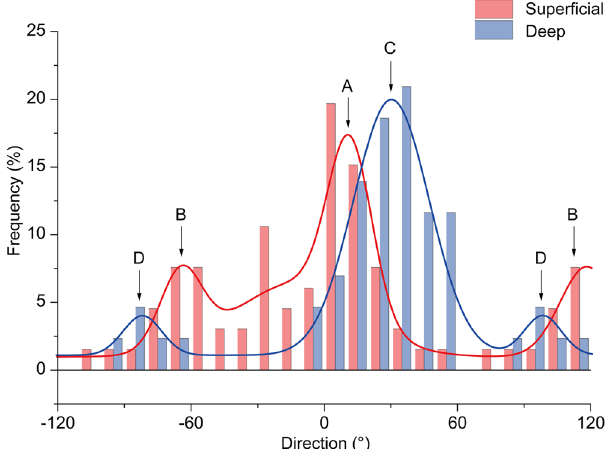
Figure 5. Characterizing the distribution of collagen fibers in the superficial and deep reticular layers. Histogram of the orientation angles of collagen fibers in the superficial reticular dermis (red) and deep reticular dermis (blue) and a representative cumulative curve with Gaussian fitting (RD-6) are shown. Arrows A–D point to the centers of the Gaussian fitting. In this example, collagen fiber bundles have a bimodal distribution, where A and B are the modes with the highest peaks (Mode 1). In contrast, B and D are the modes with the next highest peaks (Mode 2).